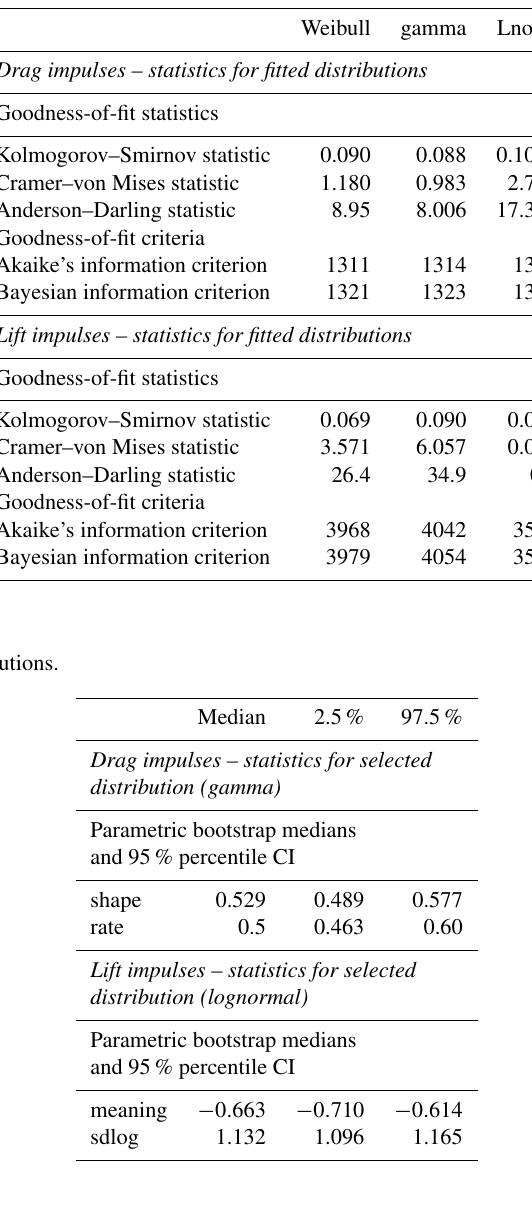
Table F1. Fitted distribution statistics.